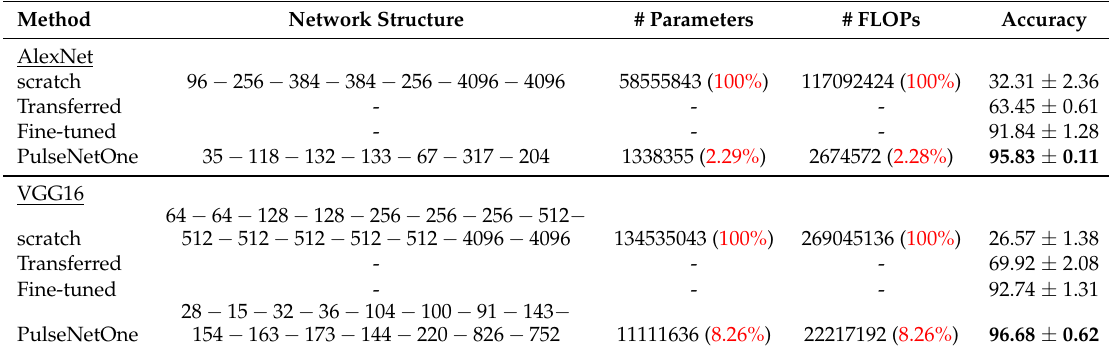
Figure 2. Barcharts for AlexNet and VGG16, illustrating the difference between the theoretical, CPU and GPU efficiency with respect to their computational speed and energy consumed on the AID dataset. Table 4. Overall accuracies and standard deviations (%) of different CNNs methods along with PulseNetOne on the MIT67 dataset. The entries in bold show the method with the best classification for the network, while the percentage of the original network is highlighted in